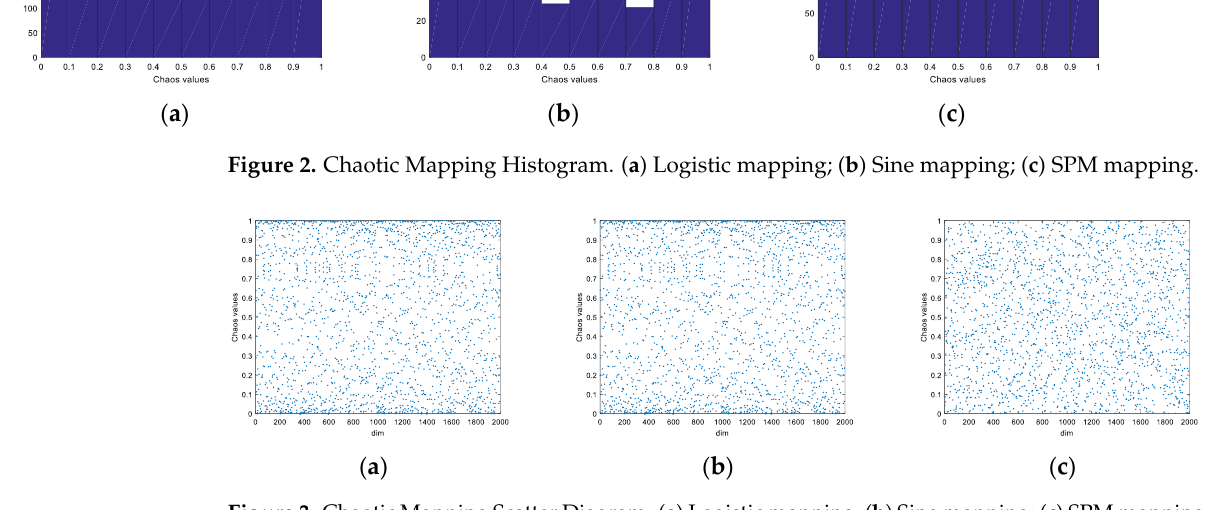
Figure 3. Chaotic Mapping Scatter Diagram. ( a ) Logistic mapping; ( b ) Sine mapping; ( c ) SPM mapping.